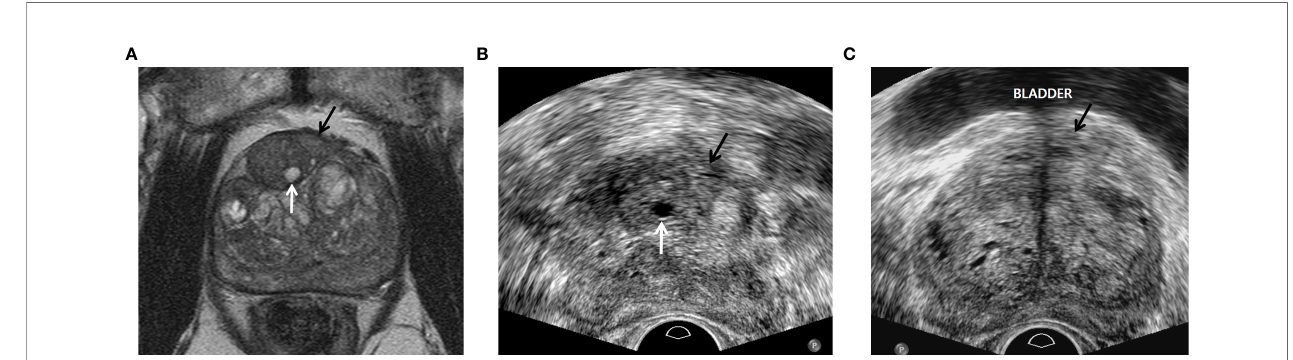
FIGURE 2 | A 77-year-old man with PSA of 9.57 ng/ml. (A) T2-weighted axial magnetic resonance image showing a PI-RADS 4 transition mass (black arrow) in the left base. The tumor is contacting the anterior capsule. The white arrow indicates a small cyst in the neighboring hyperplastic nodule. (B) Transverse TRUS image scanned by radiologist A showing a slightly hyperechoic mass (black arrow) in the left mid-gland. The tumor was targeted with four cores of which three were GS 6 and one was negative. Sextant systematic biopsy was also performed, but all of the cores were negative. The white arrow indicates a small cyst in the neighboring hyperplastic nodule, which is the same imaging feature seen on T2-weighted MR image. This TRUS sequence is fundamental imaging with low dynamic range, resulting in good contrast between the PI-RADS 4 lesion and normal tissue. (C) Transverse TRUS image, which was scanned by radiologist B two months before beginning our study period, shows a slightly hypoechoic mass (black arrow) in the left base contacting the bladder base. The tumor was targeted with three cores of which all were negative. Systematic biopsy was also performed with 10 cores of which all were negative. Radiologist B did not detect the neighboring hyperplastic nodule with a small cyst that was seen on the T2-weighted MR image. This TRUS sequence is harmonic imaging with high dynamic range, subsequently leading to poor tissue